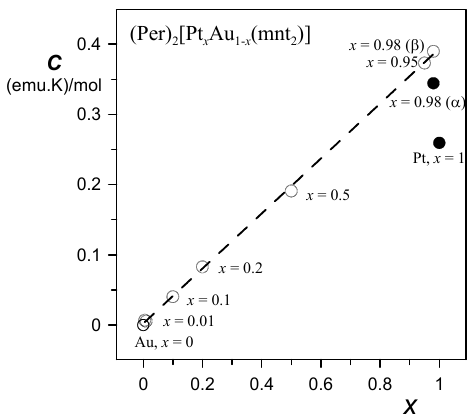
Figure 6. Curie constant, C, of the [Pt(mnt) 2 ] contribution to the paramagnetic susceptibility of (Per) 2 [Pt x -Au (1 − x ) (mnt) 2 ] as a function of the composition x .